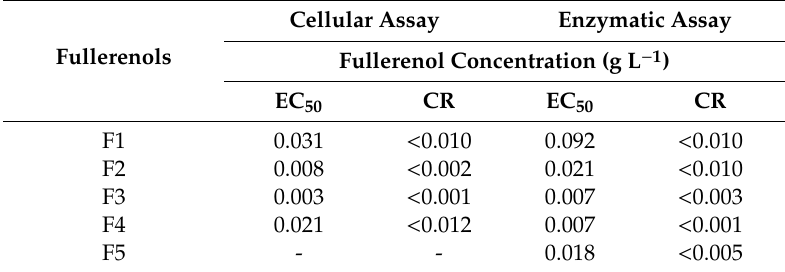
Table 2. Values of effective concentrations EC 50 of fullerenols F1–F5 and concentration range (CR) of F1–F5 for decreasing bioluminescent intensity less than 10% for both enzymatic and cellular assays.